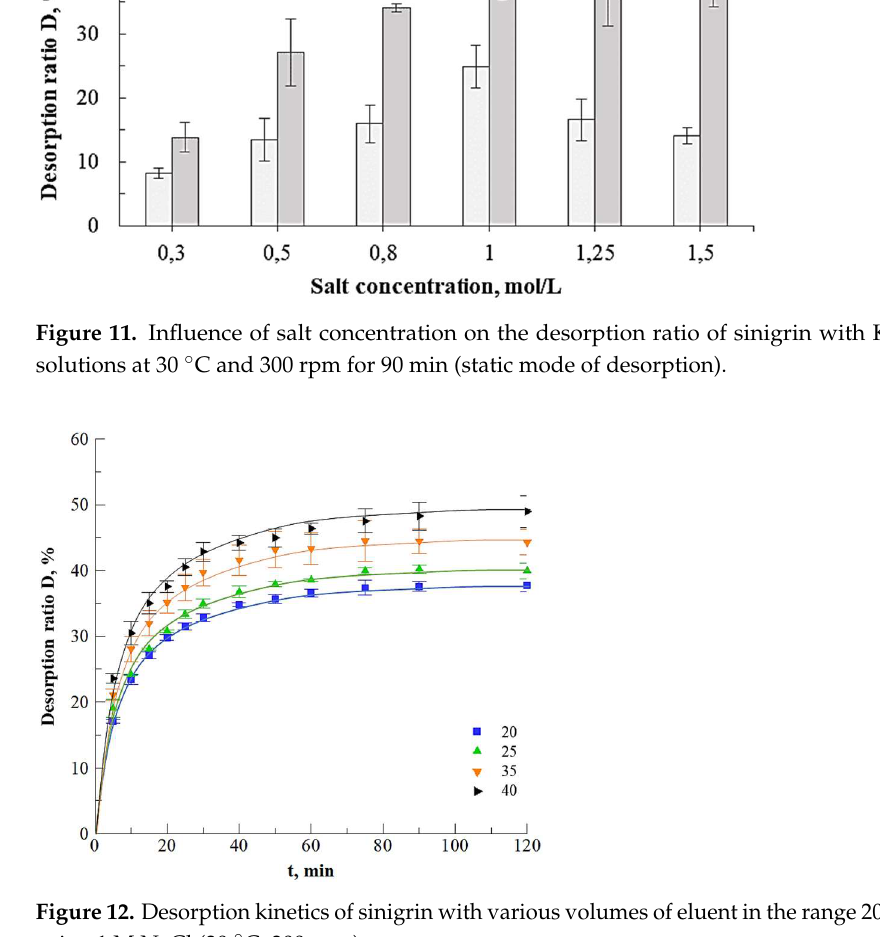
Figure 12. Desorption kinetics of sinigrin with various volumes of eluent in the range 20–40 mL/g resin using 1 M NaCl (30 °C, 300 rpm).